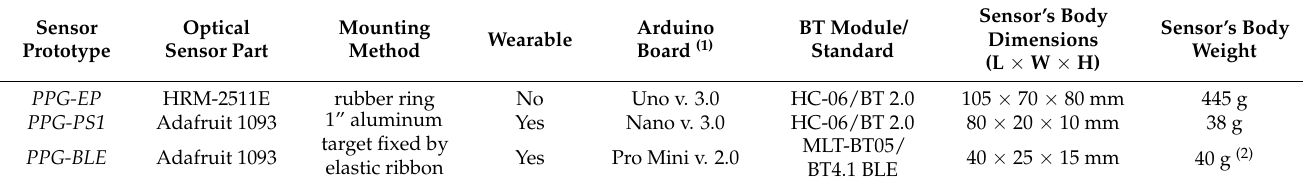
Table 1. Differences in an architecture, basic components, and mechanical realizations of all three PPG sensor